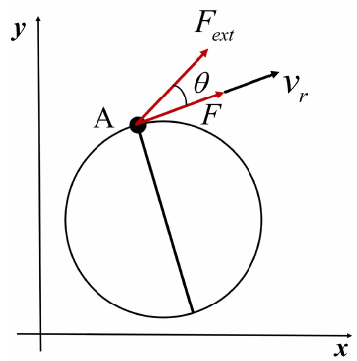
Figure 6. Interaction force F ext and target velocity v r